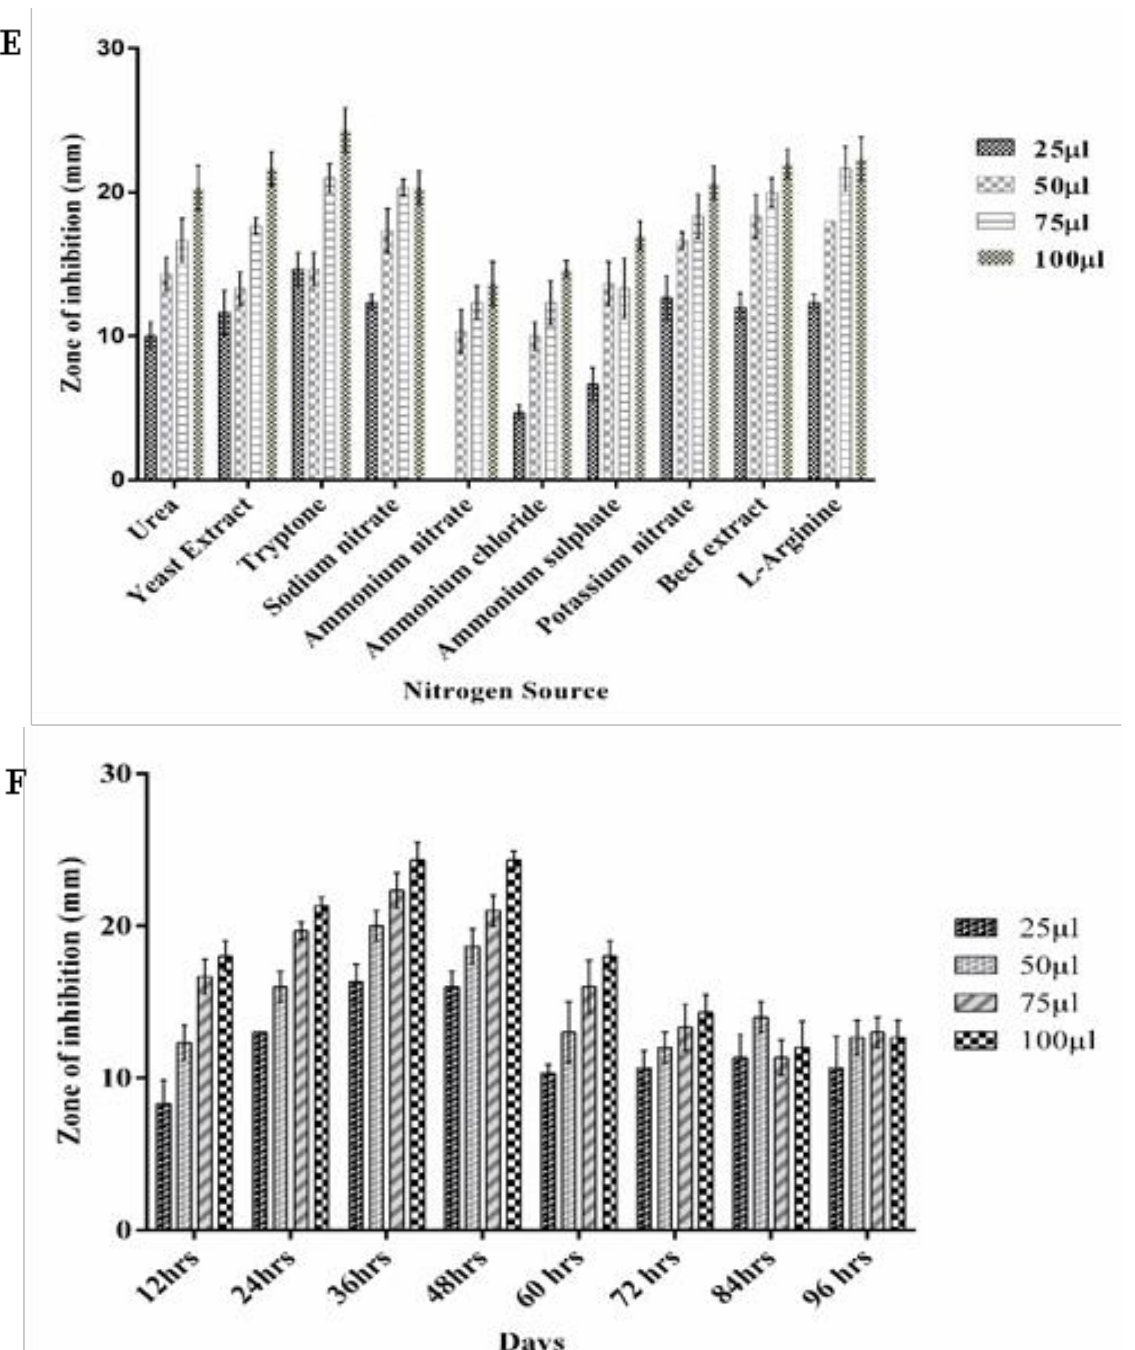
Figure 4. Optimization of P. fluorescens VSMKU3054 biomass with various abiotic parameters. ( A ) Medium, ( B ) temperature, ( C ) pH, ( D ) carbon sources, ( E ) nitrogen sources and ( F ) time.